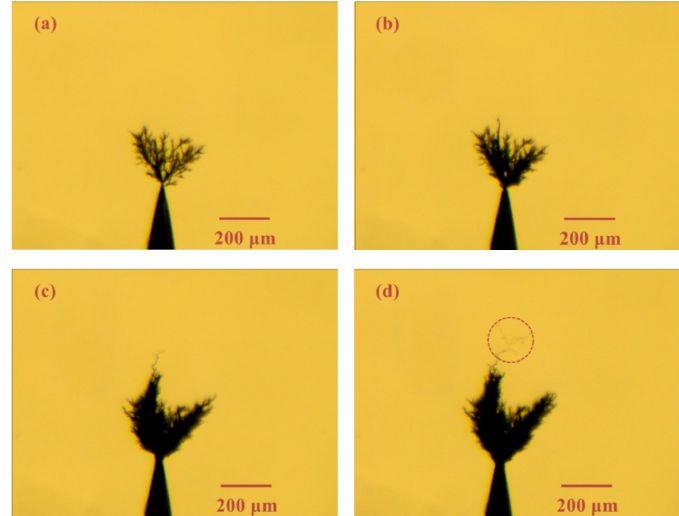
Figure 5. Electrical tree morphology in epoxy casting insulation sample with small air gap under